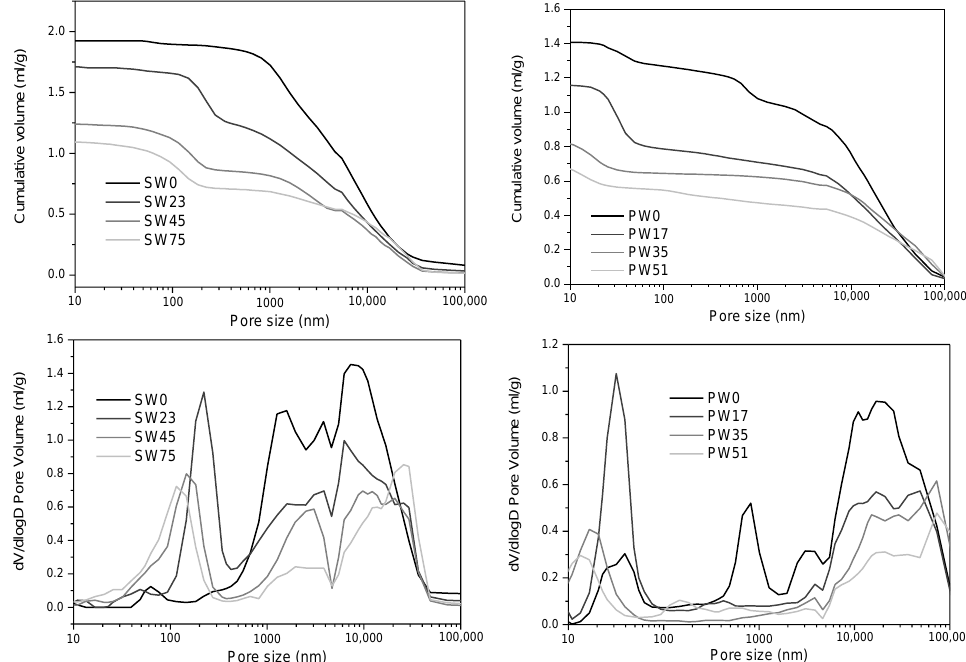
Figure 1. Cumulative pore volume and log-differential intrusion versus pore size of Chinese fir ( left ) and poplar ( right ).